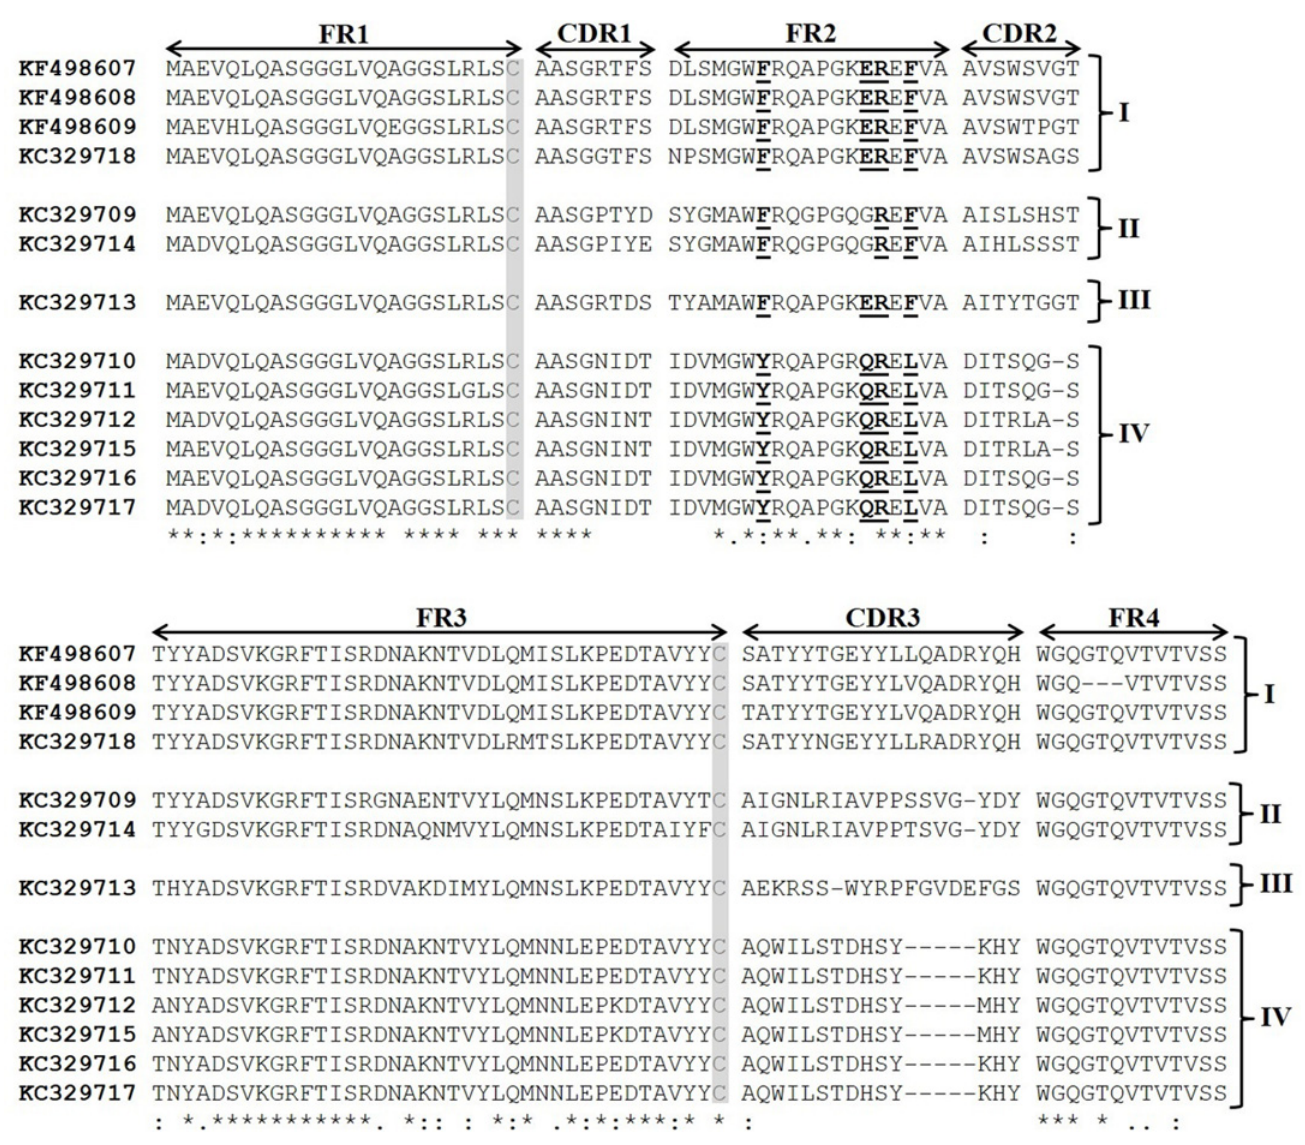
Fig 2. Amino acid sequence alignment of anti-BthTX-I and BthTX-II VHHs. The clones were clustered in four groups based on sequence homologies. The framework regions (FR) as well as the complementarity determining regions (CDR) are indicated with arrows; two conserved cysteines are shaded; VHH hallmark substitutions in FR2 and FR4 are bolded and underlined. Cluster I (KF498607, KF498608, KF498609, and KC329718), Cluster II (KC329709, KC329714), Cluster III (KC329713), and Cluster IV (KC329710, KC329711, KC329712, KC329715, KC329716, KC329717). The colon (:) represents highly conserved amino acids; the asterisk ( * ) represents identical amino acid residues; the period (.) means somewhat similar but different amino acids and blank represents dissimilar amino acids or